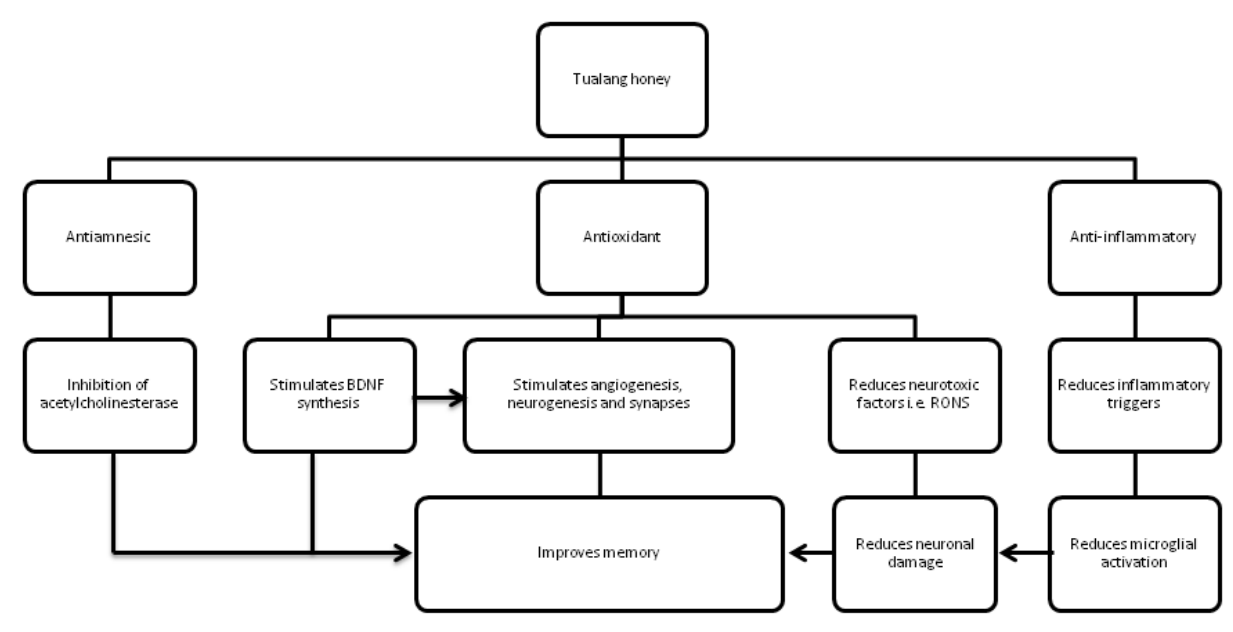
Figure 1. Proposed roles of Tualang honey in learning and